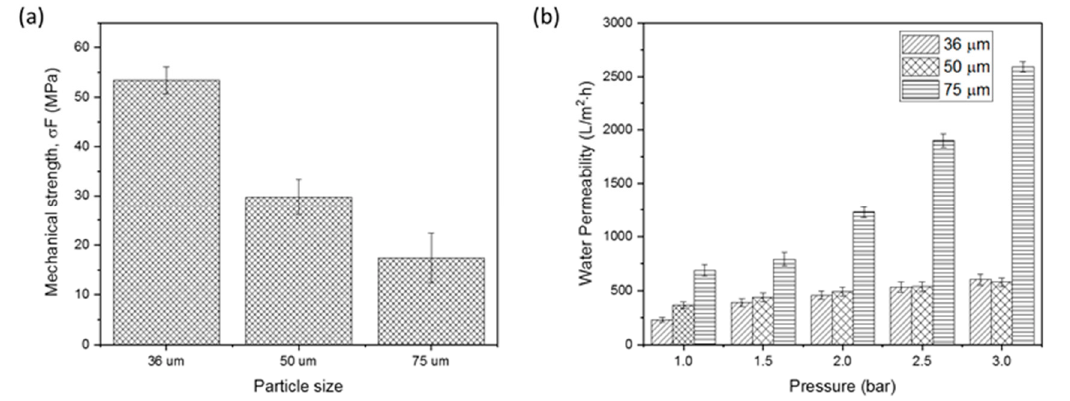
Figure 8. ( a ) The mechanical strength of the HFCM derived from different grade of natural zeolite particle sizes (n = 5) and ( b ) pure water permeability profile of the HFCM derived from different grade of natural zeolite particle sizes at different water pressure (n = 3).